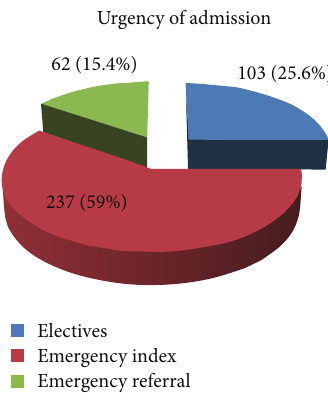
Figure 1: Urgency of